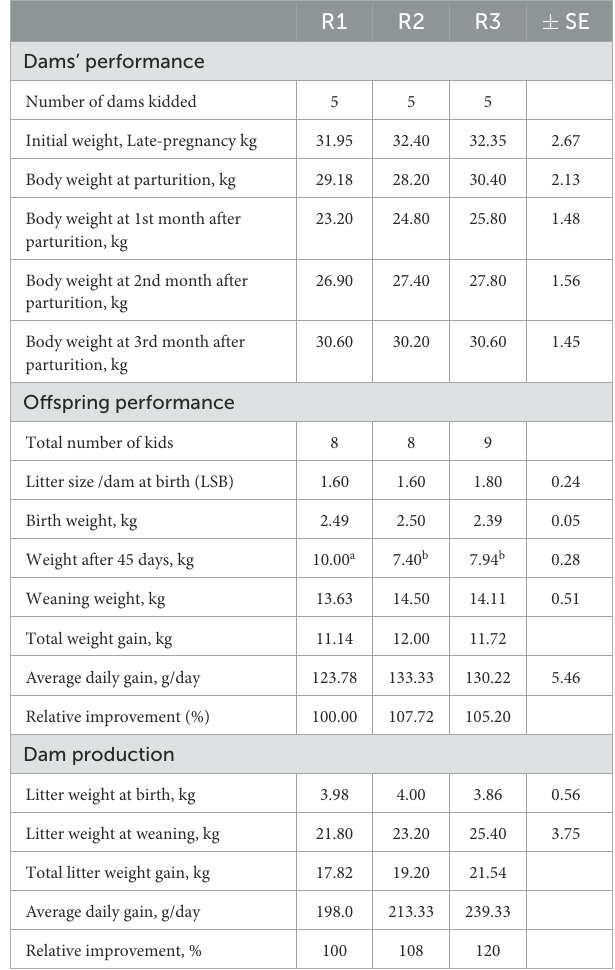
TABLE 7 Performance effects of feeding dams and their offspring sun dried azolla meal